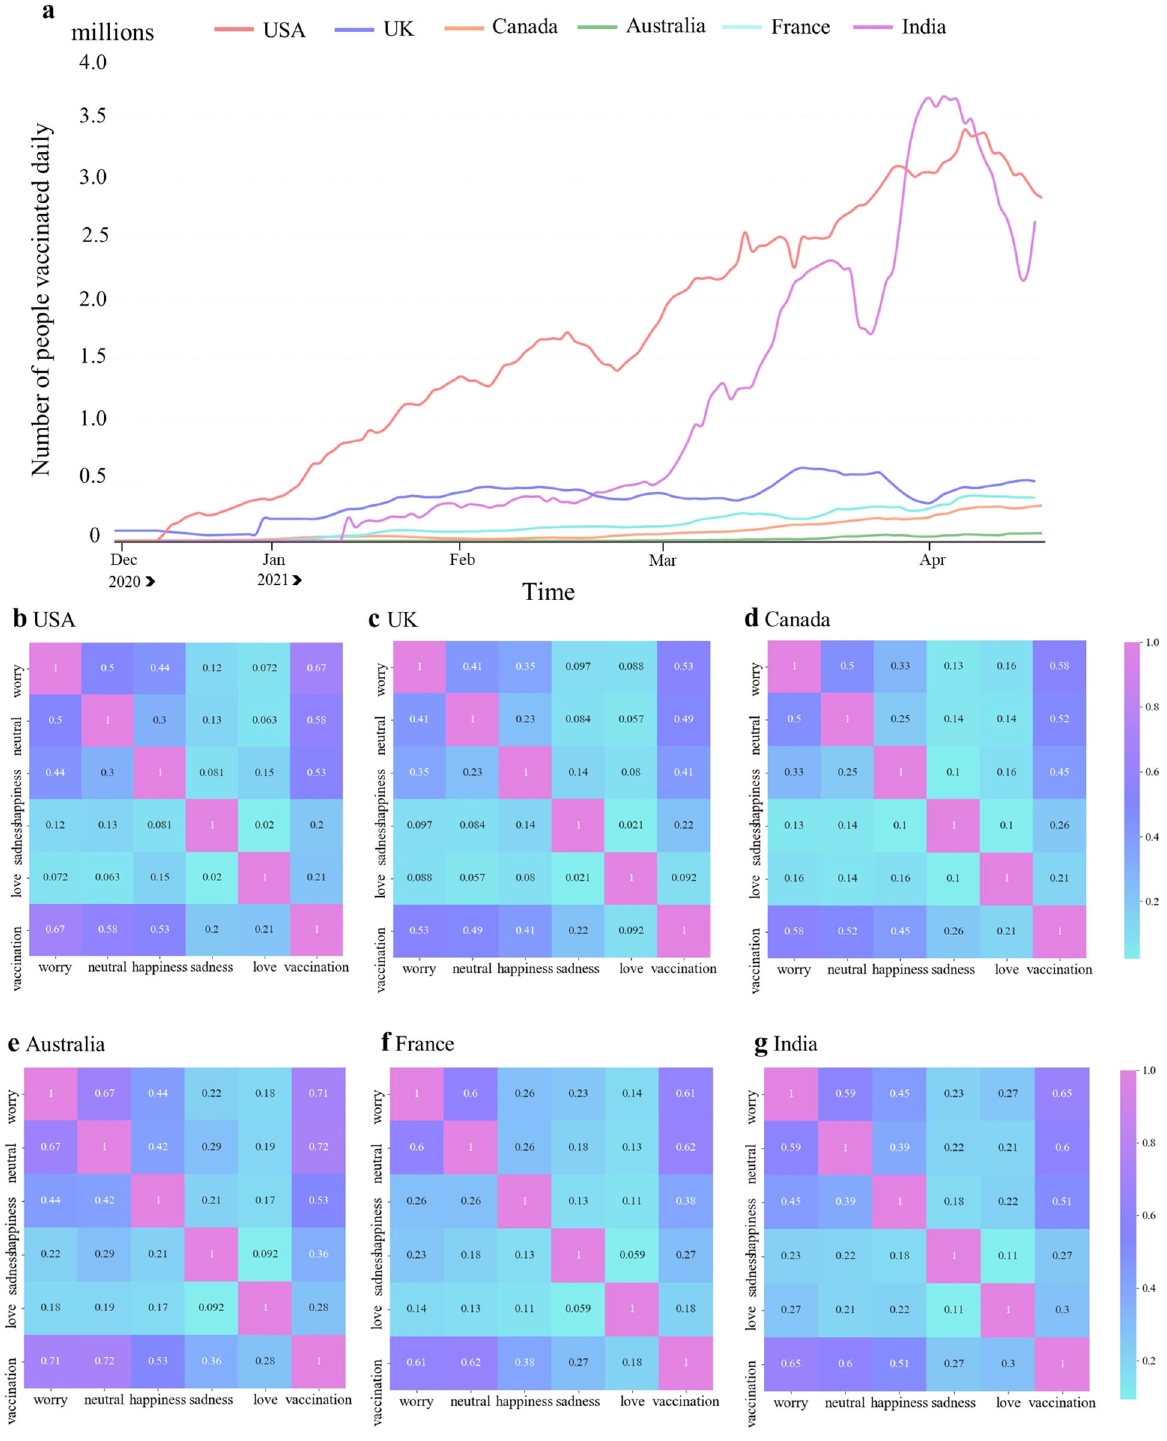
Fig. 5 Vaccination status in some typical countries and a heatmap of the correlation between vaccination and emotions. a Number of daily vaccinations. b – g Heatmap of the correlation between vaccination and emotions in the USA, the UK, Canada, India, France, and Australia calculated by the normalized mutual information method. With the progress of global vaccination, netizens ’ emotion of worry has the highest correlation with vaccination (see the